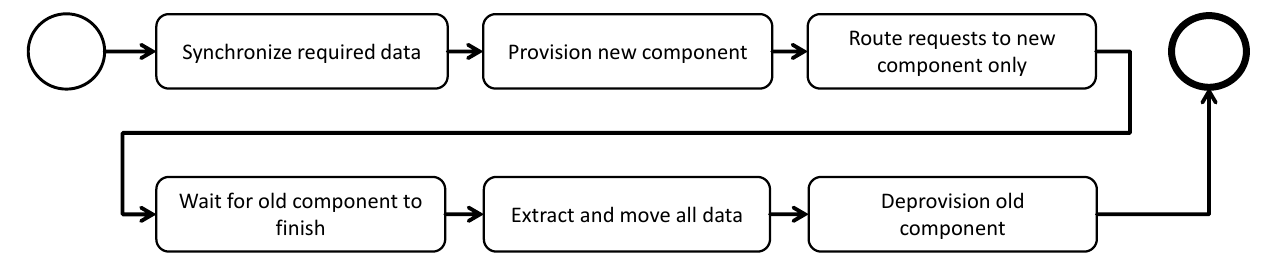
Figure 13. Icon of the Move/Update Management without Downtime Pattern.